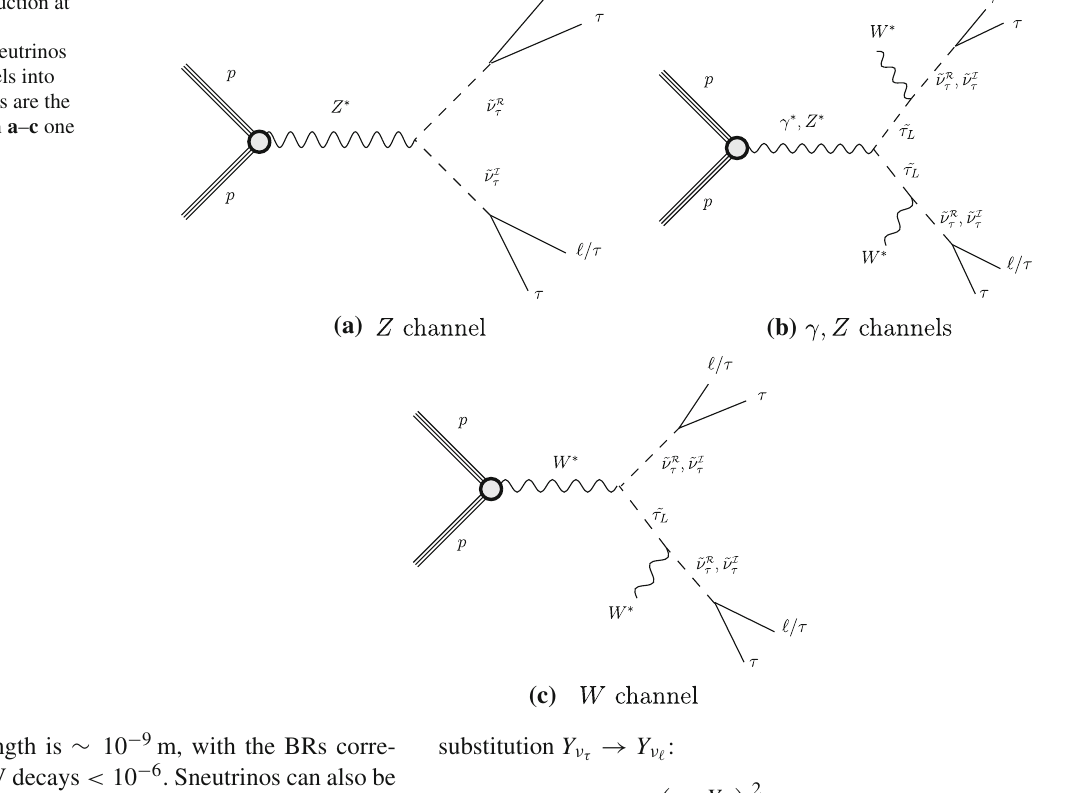
Fig. 1 Decay channels into two τ (cid:12)/τ , from a pair production at the LHC of scalar and pseudoscalar tau left sneutrinos co-LSPs. Decay channels into one τ (cid:12)/τ plus neutrinos are the same but substituting in a – c one of the two vertices by a two-neutrino